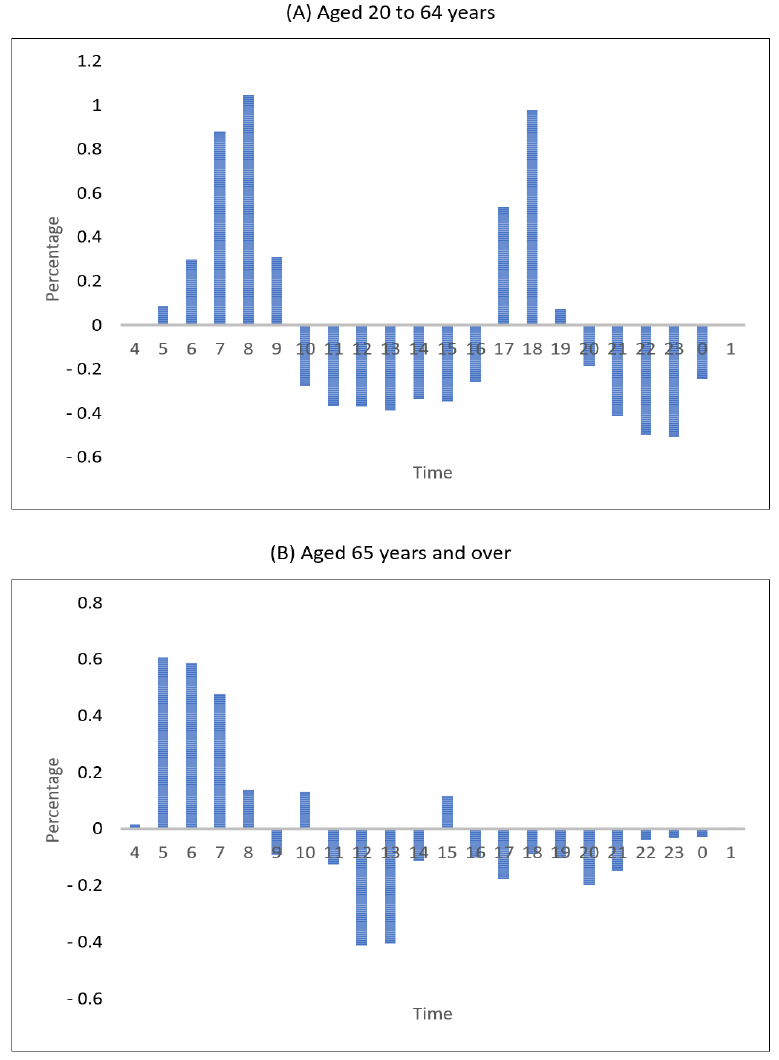
Figure 5. Change in the share of subway use hours.